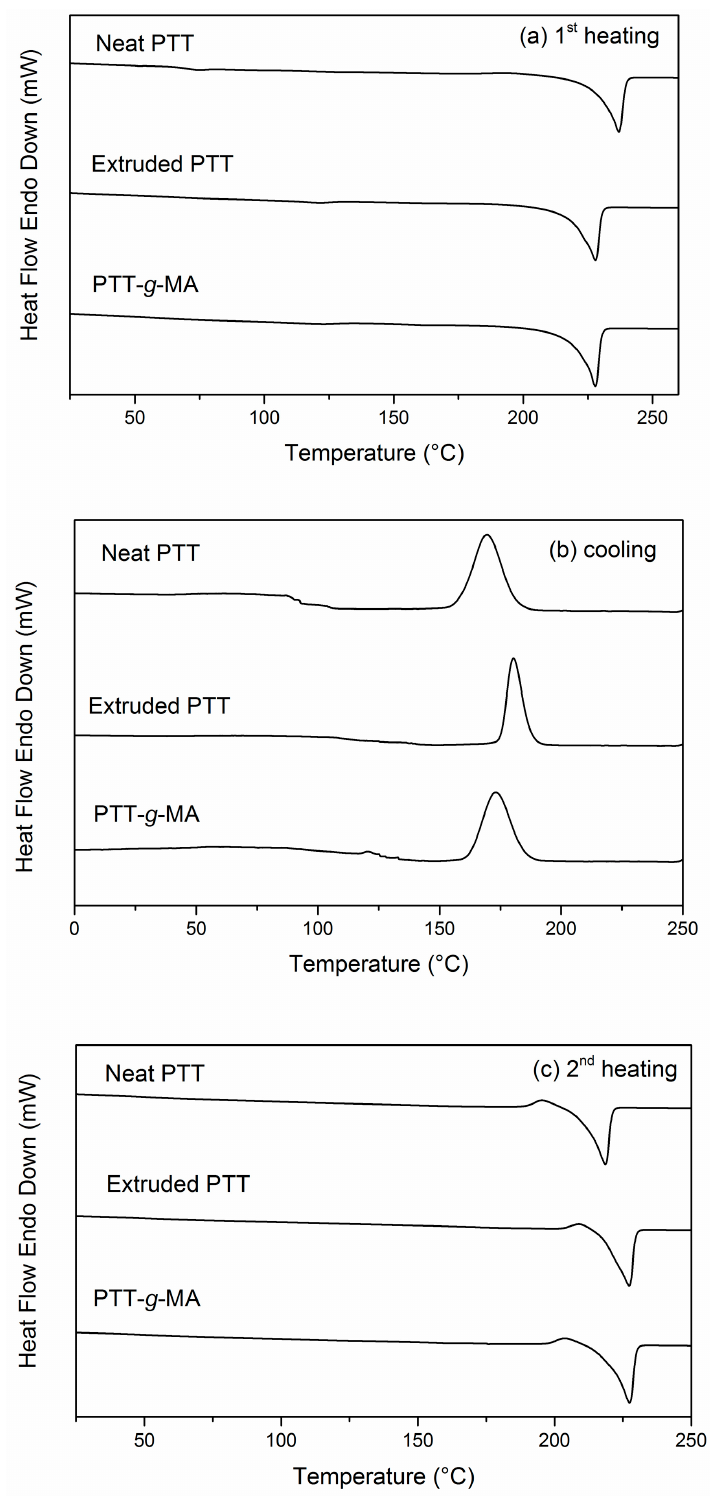
Figure 4. DSC thermograms for neat PTT, extruded PTT, and PTT- g -MA: ( a ) first heating, ( b ) cooling, and ( c ) second heating.